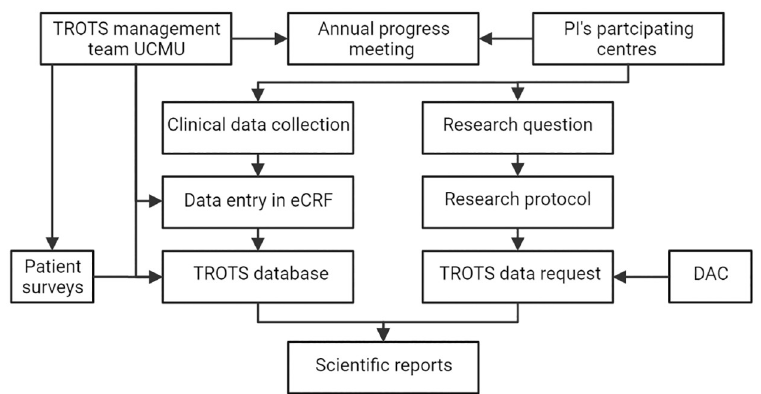
Fig 1. Flowchart of TROTS registry structure. TROTS: thoracic outlet syndrome, UMCU: University Medical Centre Utrecht, PI: principal investigator, eCRF: electronic case report form, DAC: data access committee.